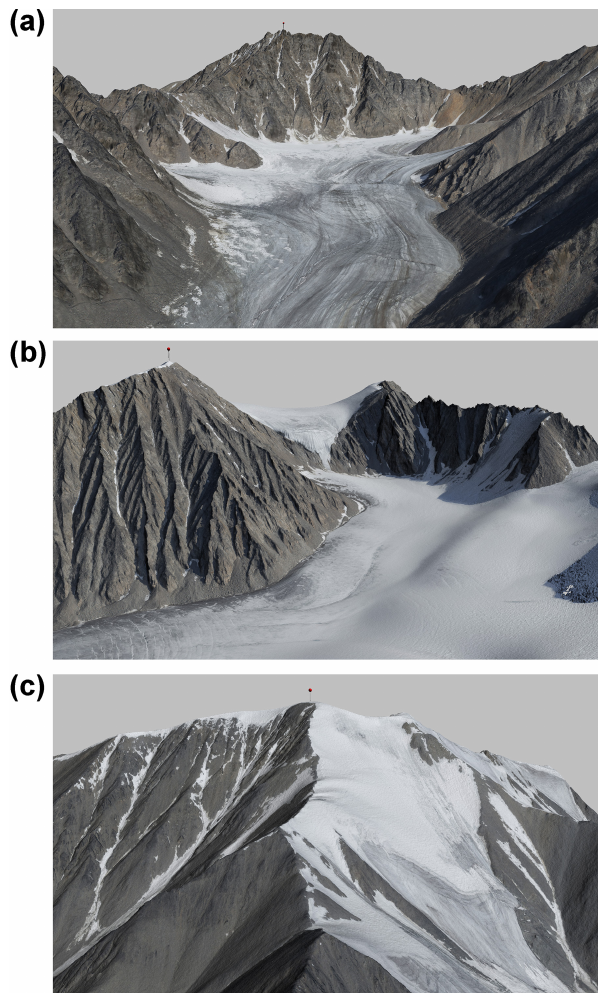
Figure 4. Oblique 3-D visualizations using our fodar data of (a) the south face of Mt. Hubley with Schwanda Glacier in foreground, (b) the south face of Mt. Michelson descending to Esetuk Glacier, and (c) the south and east faces of Mt. Okpilak. Red markers indi- cate peak location. Note the slight noise seen at the shadow on the right of (b) ; this was common at the edge of dark, fast-moving shad- ows. Despite the range of exposure value and contrast, this tech- nique is able to map nearly all terrain, and the orthoimage elimi- nates guesswork when it comes to distinguishing rock and ice and even ice and